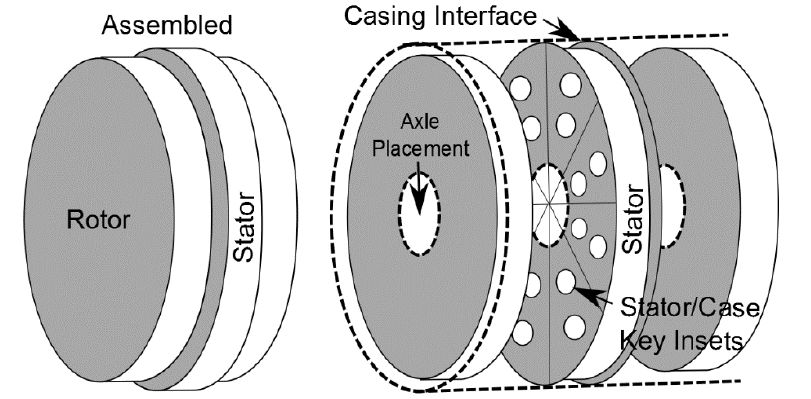
Figure 20. AFSRM assembly components and structure. The stator key insets attach to